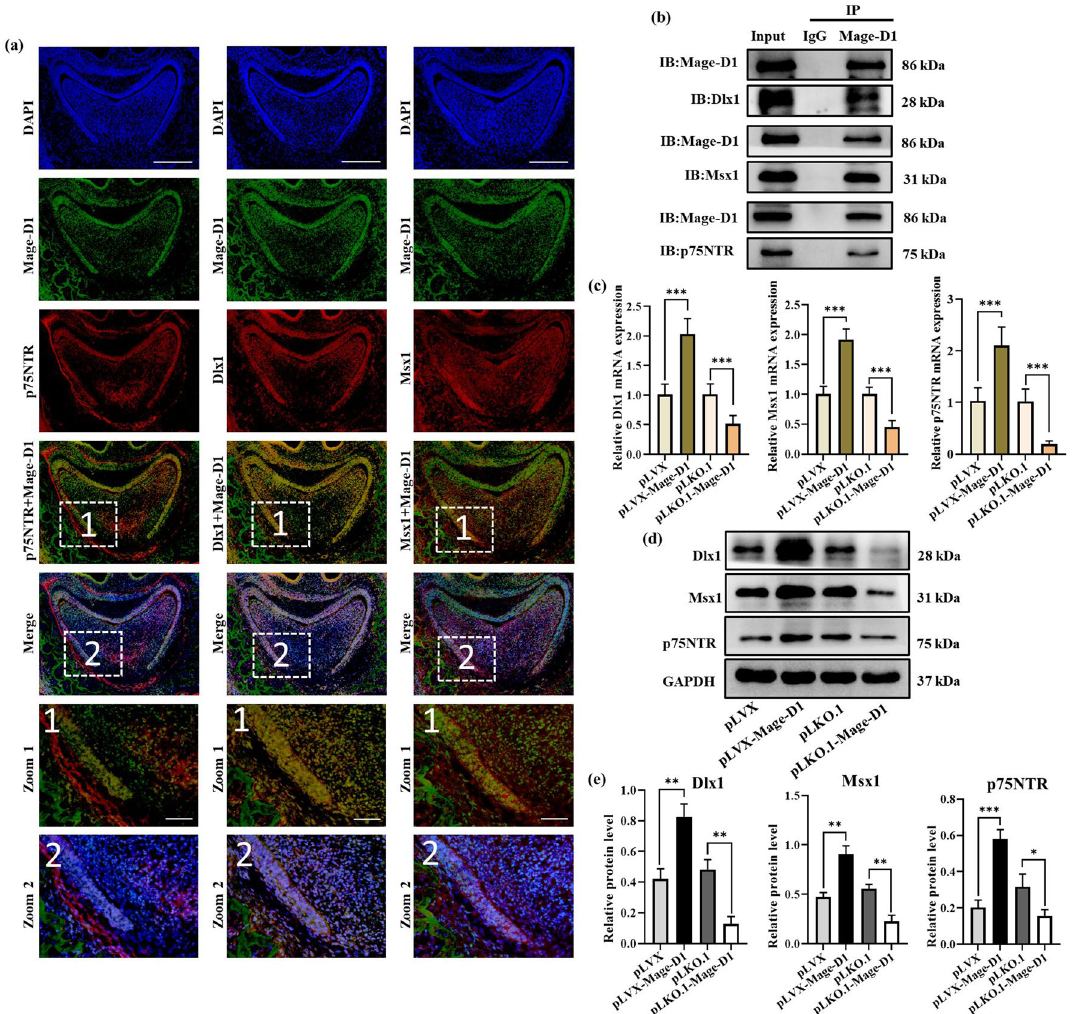
Figure 6. Investigations revealing the potential mechanism of Mage-D1 in mineralization. ( a ) Immunofluorescence double staining of Mage-D1, p75NTR, Dlx1 and Msx1 at E19.5 d rat dental germ. Scale bar represents 200 μm or 50 μm. ( b ) Co-immunoprecipitation shows that Mage-D1 can bind to p75NTR, Msx1, Dlx1 based on E19.5 d EMSCs. Full-length blots are presented in Supplementary Fig. S5. ( c ) Under induction with mineralized culture medium for 7 d, the expression levels of p75NTR, Msx1, Dlx1 were examined by real-time PCR normalized to GAPDH. For raw data see Supplementary Table 3. (** P < 0.01, *** P < 0.001). ( d,e ) Under induction with mineralized culture medium for 14 d, the expression levels of p75NTR, Msx1, Dlx1 were detected by Western blot analysis, GAPDH used as the reference gene. Full-length blots are presented in Supplementary Fig. Mage-D1 was strongly expressed in the dental sac and cervical loop at E19.5 d, which suggested that Mage-D1 may be involved in the development of cement, periodontal ligament, alveolar bone and the formation of epithe- lial root sheath in the future. It also can be seen that Mage-D1 was also obviously expressed in the inner enamel epithelium at E19.5 d. With the development of enamel organ, the inner enamel epithelium differentiates into ameloblasts and participates in the mineralization of teeth. Then the expression of Mage-D1 strongly expressed in preodontoblast, and dental sac at PN1, which suggested that Mage-D1 may be associated with the formation of dentin. Mage-D1 is widely expressed in ameloblasts, odontoblast, alveolar bone osteoblasts, enamel matrix and epithelial root sheath at PN4, which suggests that Mage-D1 may also be involved in the development of enamel, dentin and roots. The process of tooth development is a process of enamel dentin alternate mineralization. In short, the above studies showed that Mage-D1 was expressed with temporal and spatial specificity in dental germ development and related to the development of tooth mineralization. EMSCs provide a profitable in vitro stem cell model for the study of dental morphogenesis 12 . The enamel organ entered a mature stage at E19.5, the late bell-shaped stage. Histological results showed that the expression of Mage-D1 in dental germ was at a high level at E19.5 d, which was more suitable for studying the regulatory function of Mage-D1 in vitro. Previous studies have shown, p75NTR, as a marker for isolated cranial neural